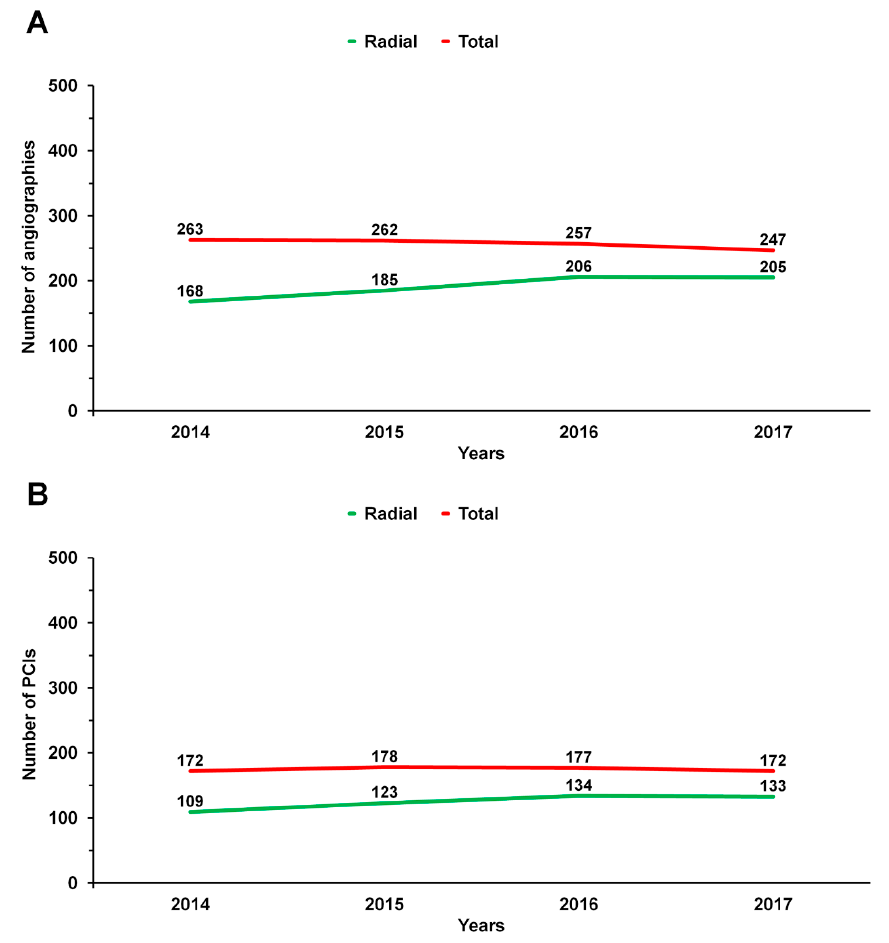
Figure 1. Median operator volume from 2014 to 2017: ( A ) for angiography; ( B ) for percutaneous coronary interventions.